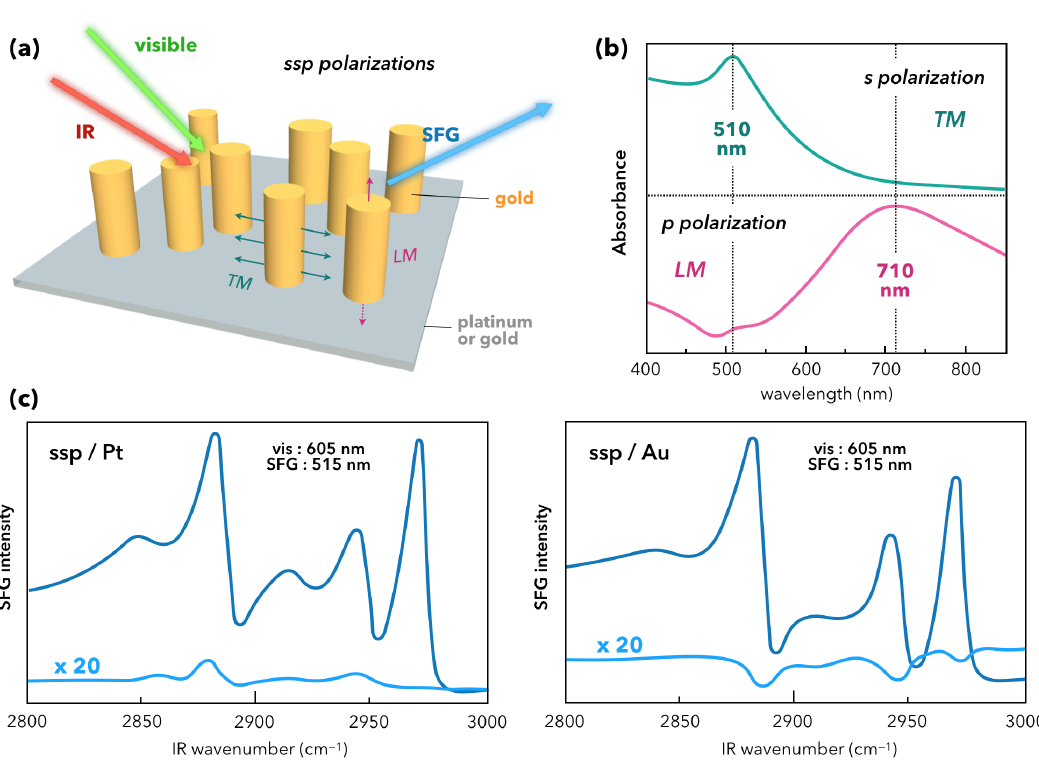
Figure 11. ( a ) Sketch of the 2C-SFG experiment on the gold nanopillars electrochemically grown on a gold or platinum surface in ssp -polarization scheme. Samples are functionalized with dodecanethiol (DDT) molecules. The electric yield enhancement of the transverse (TM) and longitudinal (LM) surface plasmon modes is depicted in green and red, respectively. ( b ) UV-Visible absorbance spectra of the sample with a gold substrate. ( c ) Comparison between the SFG spectra of the DDT/Au nanopillars/Pt ( left ) or Au ( right ) interfaces (dark blue) with respect to the DDT/Pt ( left ) or Au ( right ) interfaces (light blue). Figure panel is adapted from reference